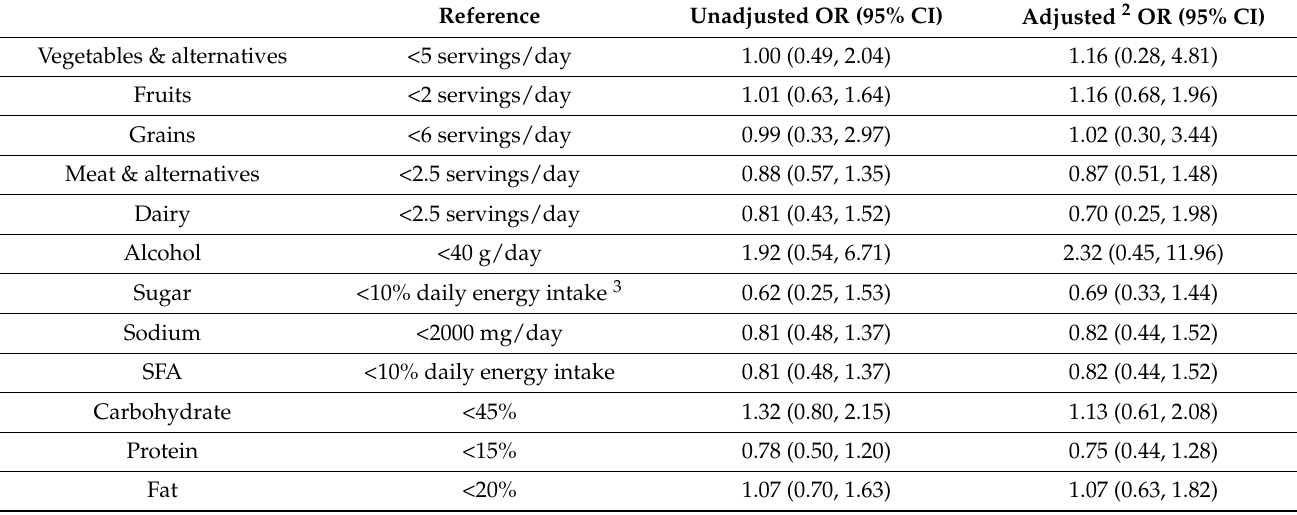
Table 3. Odds ratios for adherence to AGHE and AMDR recommendations 1